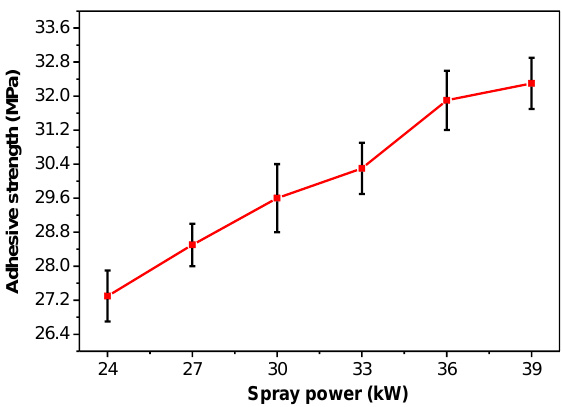
Figure 9. Adhesive strength at different spray powers.